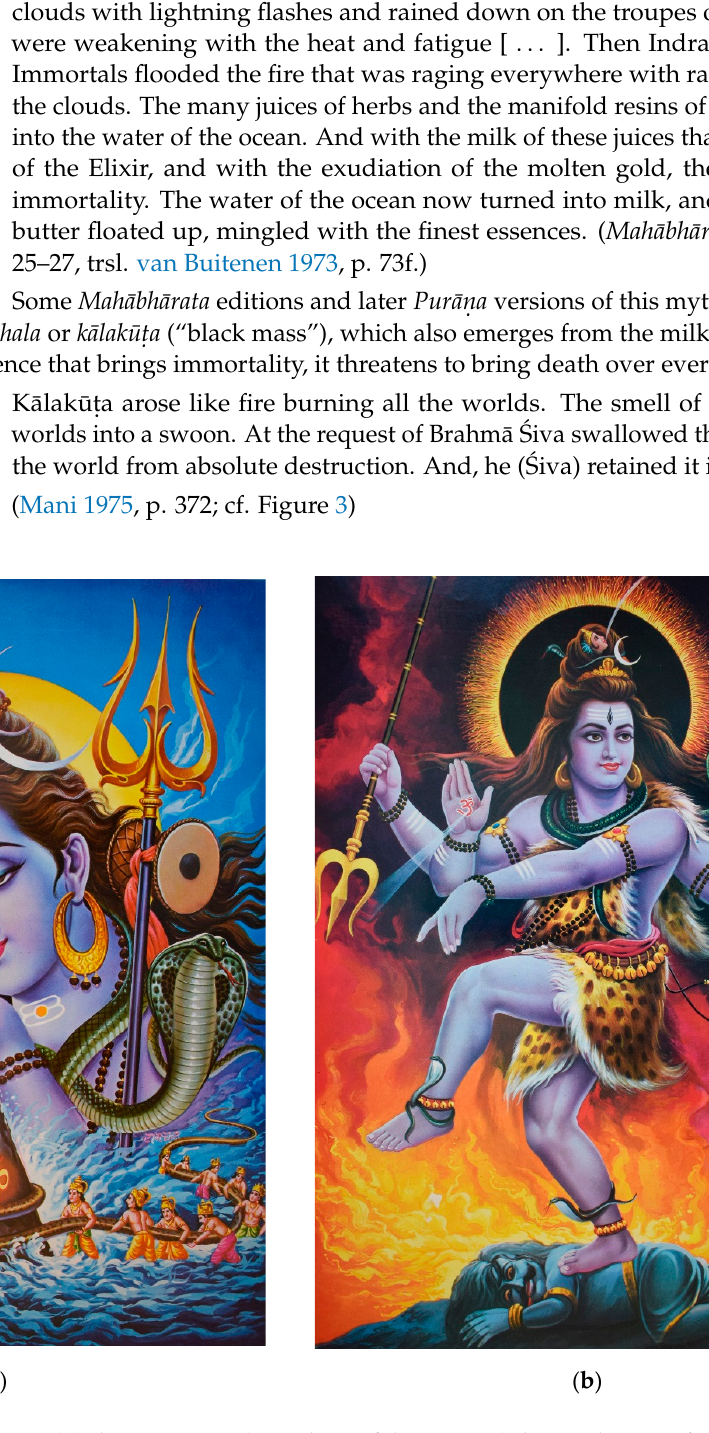
Figure 3. ( a ) Shiva’s Vis. P¯an (“Drinking of the Poison”) during the Samudramanthan (“Churning of The Ocean”); ( b ) Shiva as N¯at.ar¯aj¯a, “king of the dance” in a fiery halo (two posters by the artists Ramchand and H.R. Raja, printed by Brijbasi & Sons in Delhi. Axquired 1989 by Stephan Nagel and given to the Marburg Museum of Religions; acc. nr. B-Lp 149 14 & 6. Photos by Heike Luu, permission